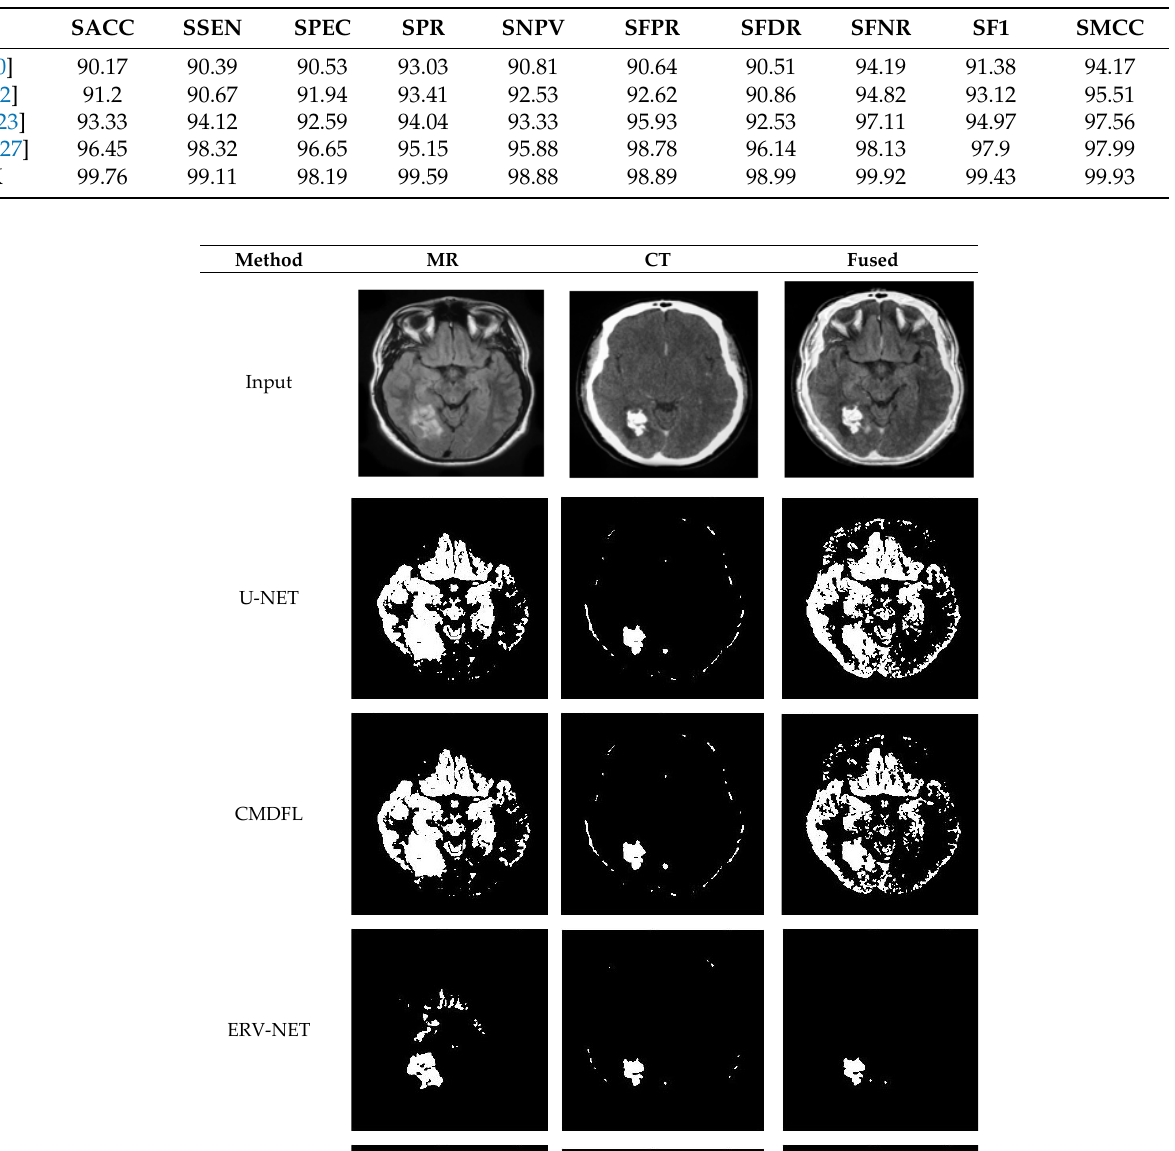
Table 8. Performance evaluation of various methodologies for segmentation in percentage.